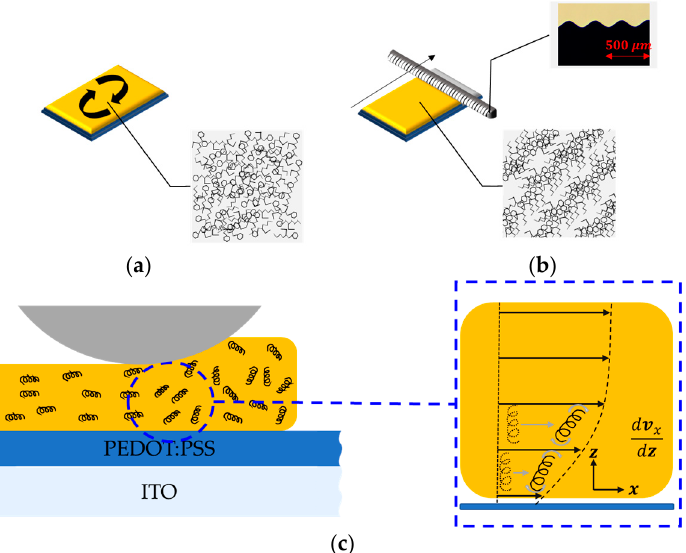
Figure 2. Two kinds of coating methods of MEH-PPV film: ( a ) spin coating and ( b ) molecular ordering coating methods, ( c ) mechanism of molecular alignment by the molecular ordering coating method.